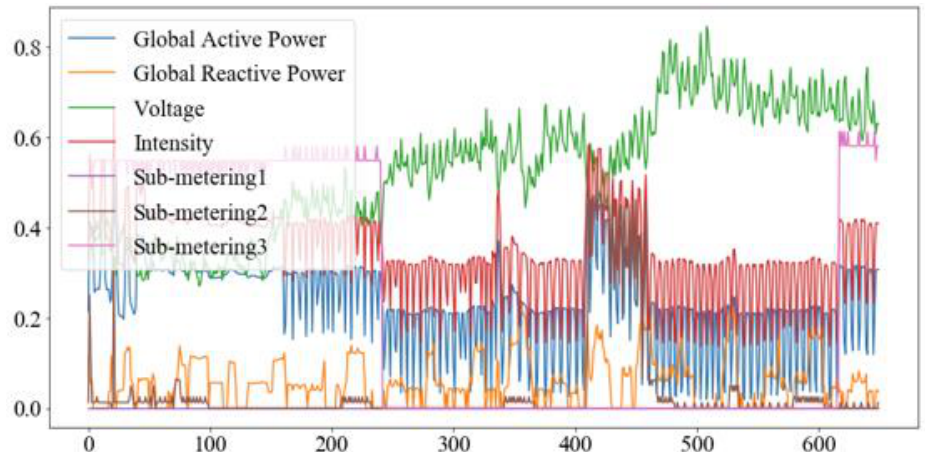
Figure 1. A typical problem formulation and the hyperparameters of the energy consumption prediction task with the resolution of the time and the time lag parameter.